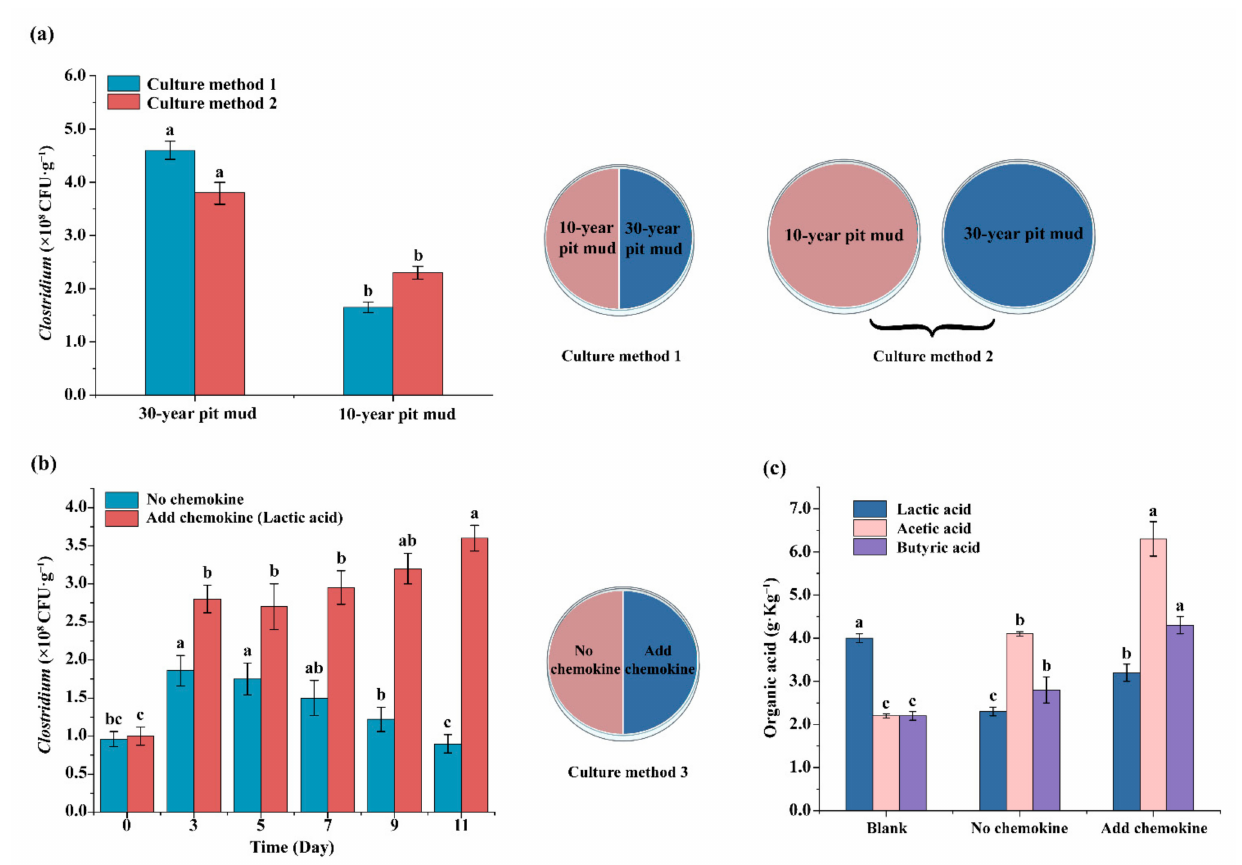
Figure 5. Migration of Clostridium in pit mud triggered by chemotaxis: ( a ) migration of Clostridium from growing pit mud to mature pit mud; ( b ) migration of Clostridium within pit mud triggered by lactic acid; ( c ) comparison of organic acids content in different pit mud samples. Letters “a–c” indicate the significant differences ( p <